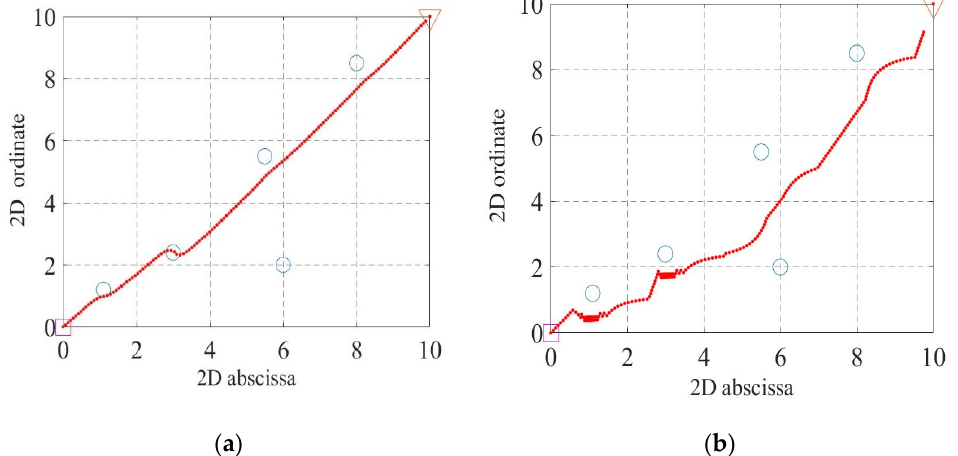
Figure 11. Simulation results when the gain coefficient is not selected: ( a ) The repulsion gain coefficient is too small; ( b ) Gravitational gain coefficient is too small.